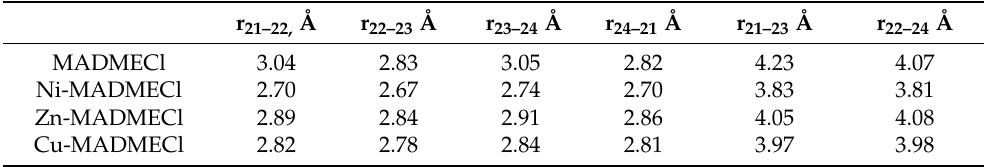
Table 2. Distances between nitrogen atoms within the macrocycle according to CAM-B3LYP/6–31 g(d,p) data (designations in the previous table).